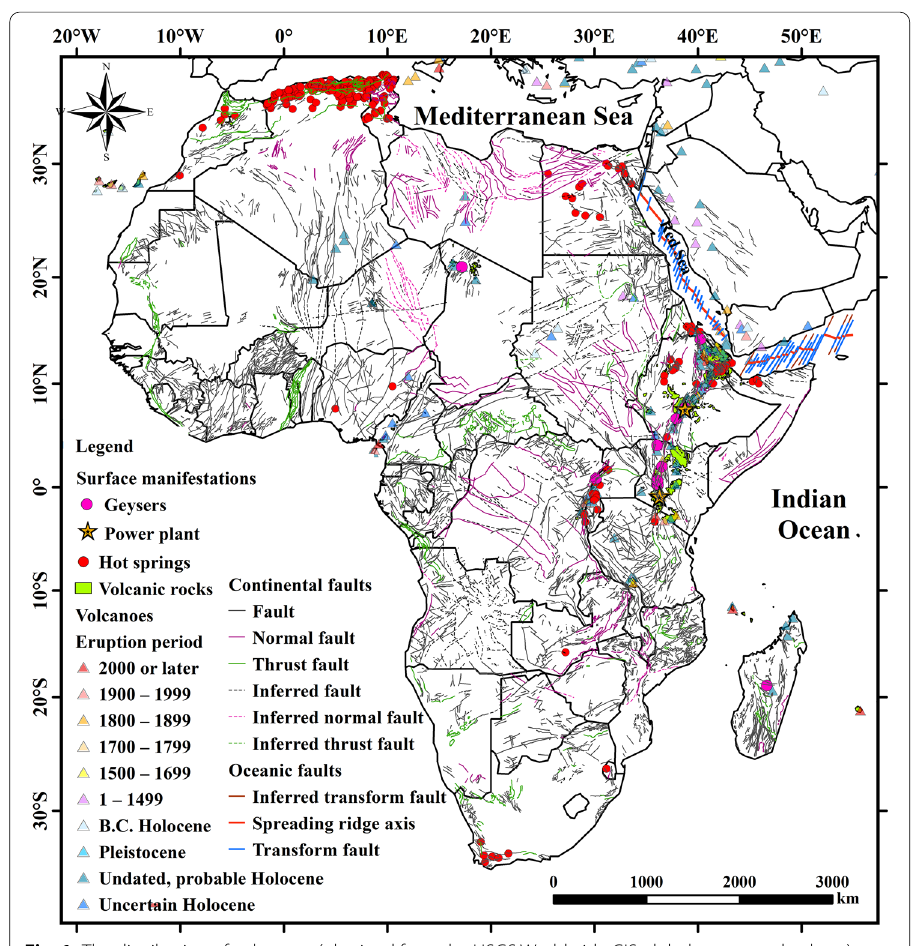
Fig. 1 The distribution of volcanoes (obtained from the USGS Worldwide GIS global coverage database), geysers (©OpenStreetMap), hot springs (Ait Ouali et al., 2019; Waring, 1983; Saibi et al., 2006), and installed geothermal power plants throughout the African continent. The map also depicts the structural elements and tectonic framework of the African continent, which were obtained from a geological map of Africa at a scale of 1:10 million (Thiéblemont et al.,